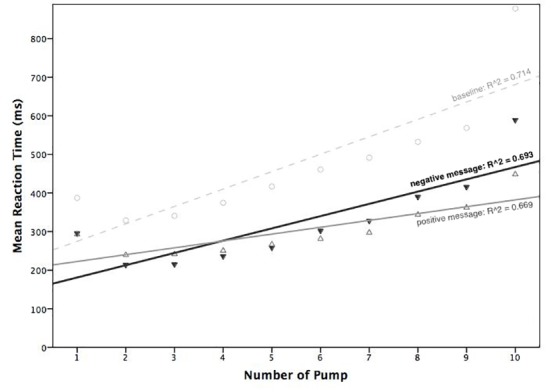
Averaged regression lines of reaction times (RTs) for inflation responses, as a function of increase in inflation step number, for each of the three blocks of trials.Note: the top light grey dashed line represents averaged regression slope in the baseline. The two bottom dark solid and grey dashed lines show averaged regression slope in the negative and in the positive message blocks, respectively. The first inflation step was excluded from all analyses (see text).